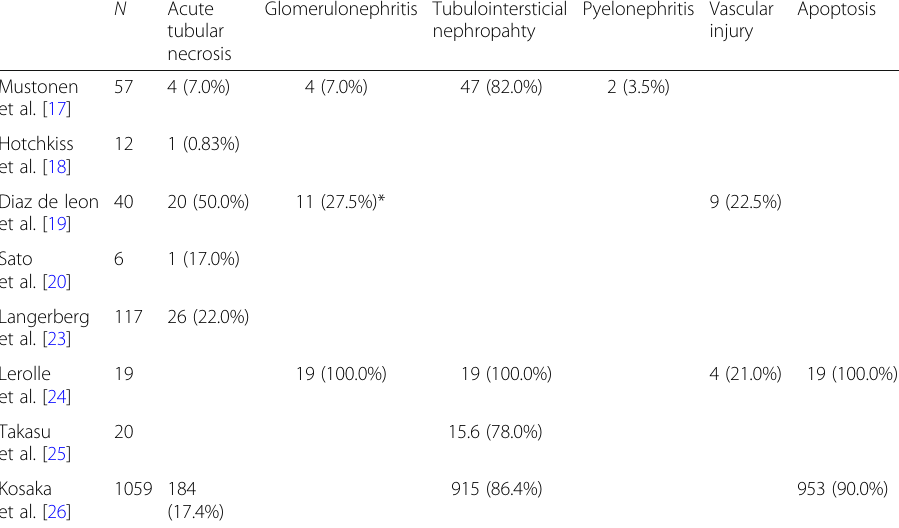
Table 1 Summary of findings from kidney tissue